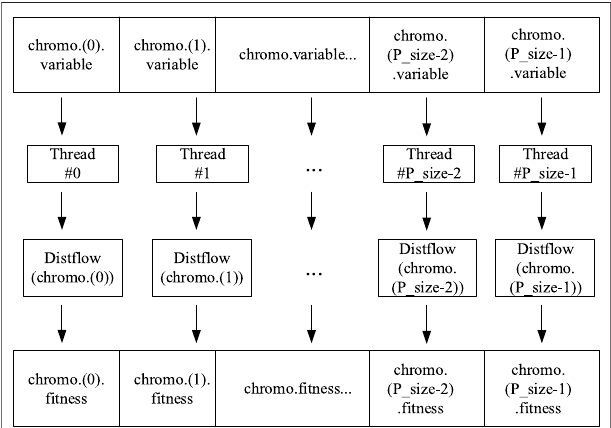
FIGURE 8 | Calculation procedure of fi tness function on GPU platform.